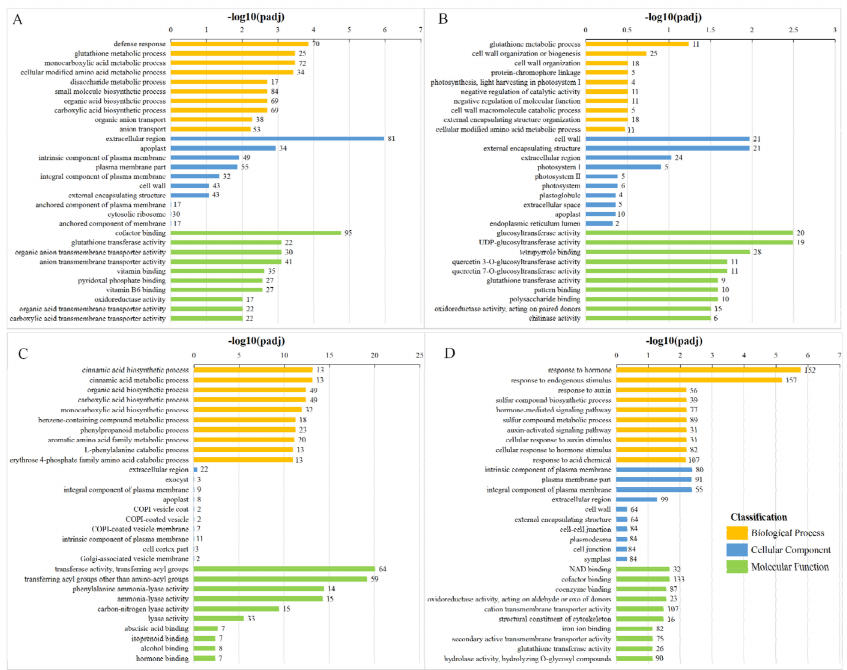
Figure 4. Gene Ontology (GO) enrichment items in different comparison groups. The horizontal axis represents the significance level of the difference. The number next to each bar represents the number of enriched DEGs. ( A , B , C , and D ) represent the comparison group of XFSUV vs XFSCK, XFLUV vs XFLCK, ZCSUV vs ZCSCK, ZCLUV vs ZCLCK,